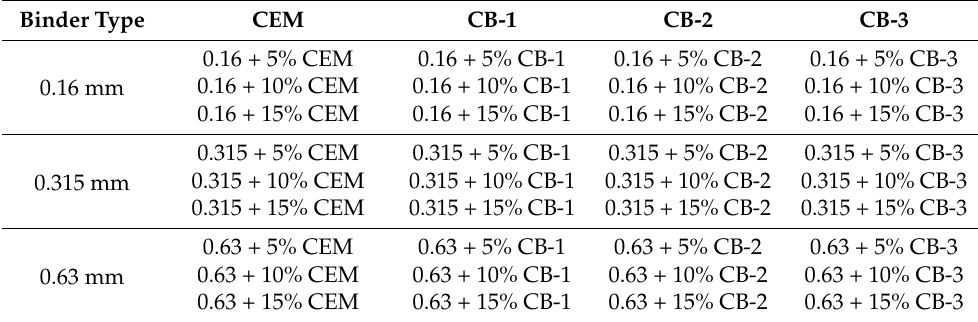
Table 3. Granular aggregate